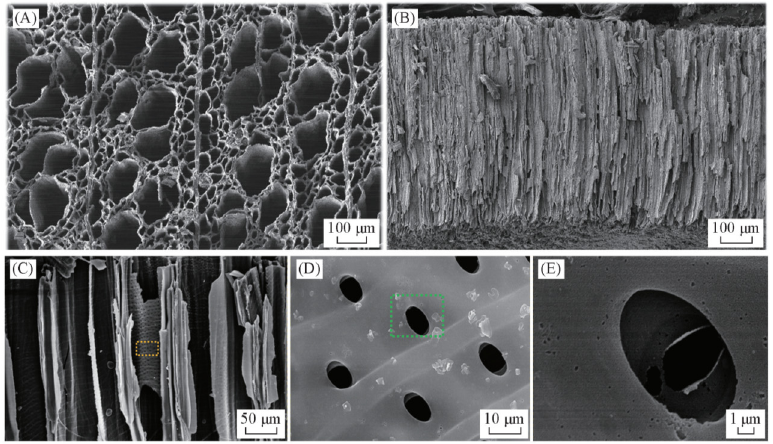
Figure 4. SEM images of activated carbon derived from wood showing ( A ) the top surface, ( B ) the side surface, ( C ) the wall of pores, ( D ) the magnified region in ( C ), ( E ) the further magnified re- gion in ( D ). Reproduced from